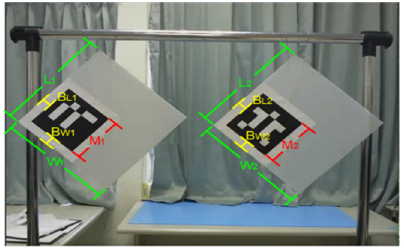
Figure 10. Suspension of the calibration boards and size markings. Table 2. Specifications of the three calibration boards.